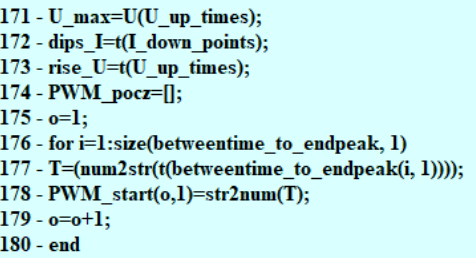
Figure 5. Searching for the sudden voltage jumps.